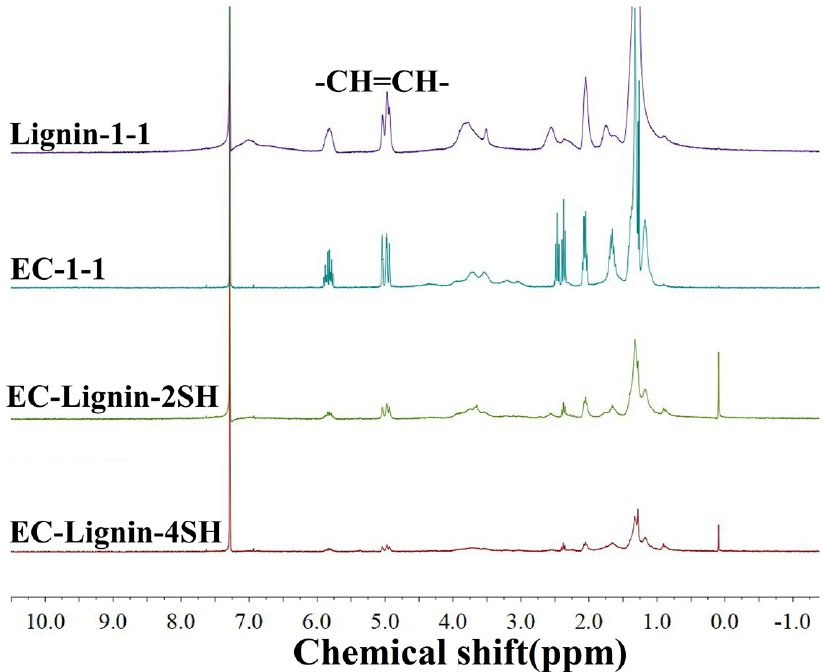
Figure 12. 1 H NMR of EC–lignin cross − linked polymer compared with those of lignin − 1 − 1 and EC − 1 − 1.